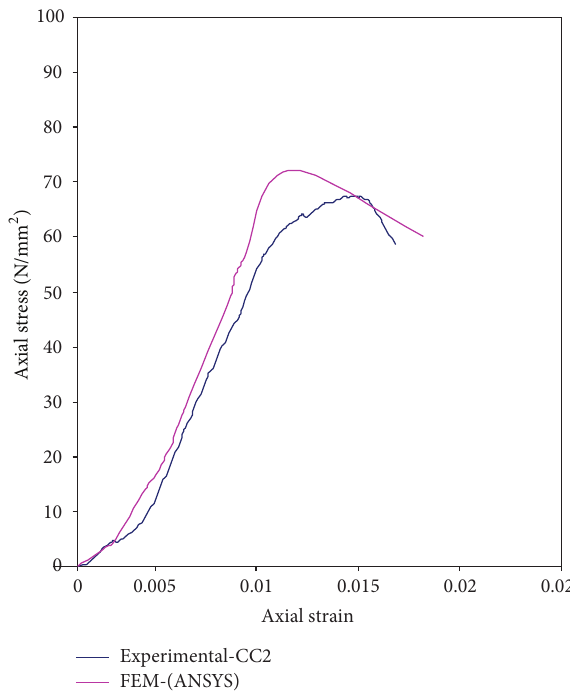
Figure 29: Comparison of experimental and computed axial stress-strain behaviours of control columns.